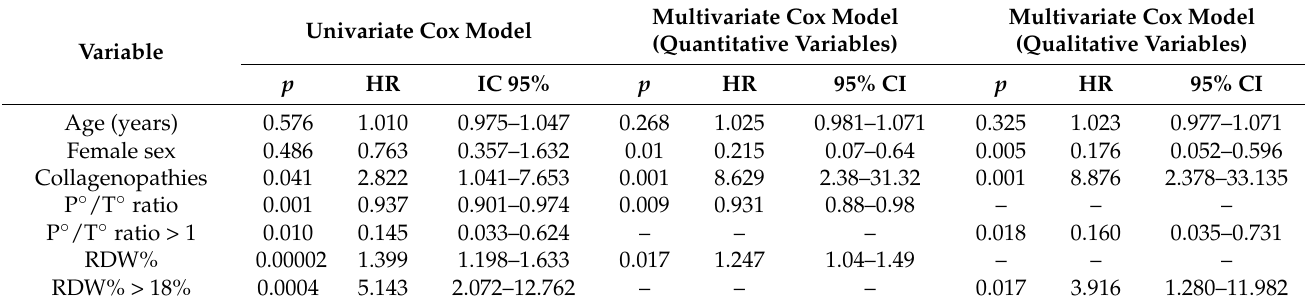
Table 3. Univariate and multivariate Cox models for severity-associated factors of pulmonary hypertension.